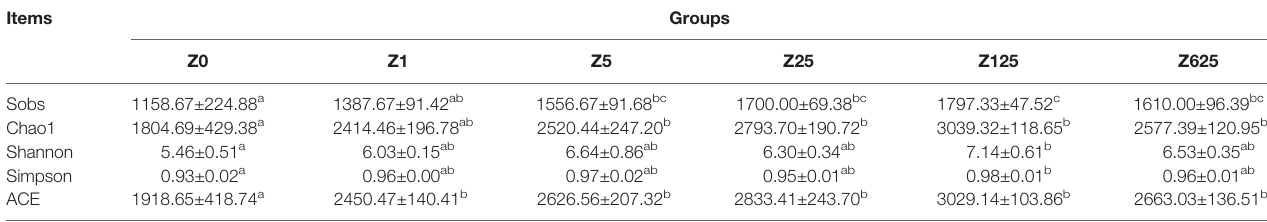
TABLE 5 | The summary of intestinal microbiota Alpha diversity indices.